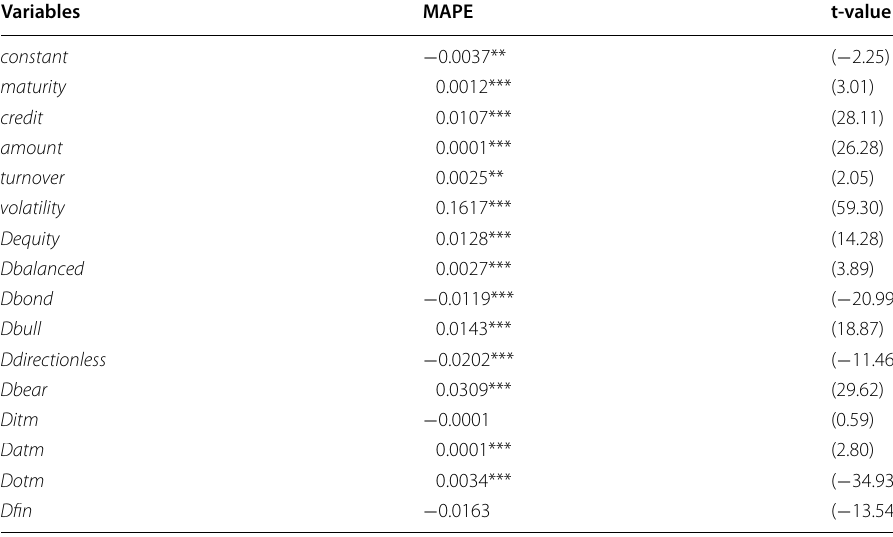
Table 6 Analysis of